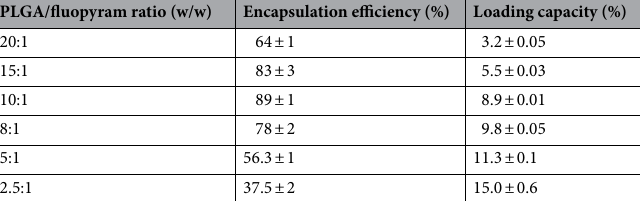
Table 2. Drug loading efficiencies and loading capacities for fluopyram-PLGA NPs prepared with different polymer/drug ratios.